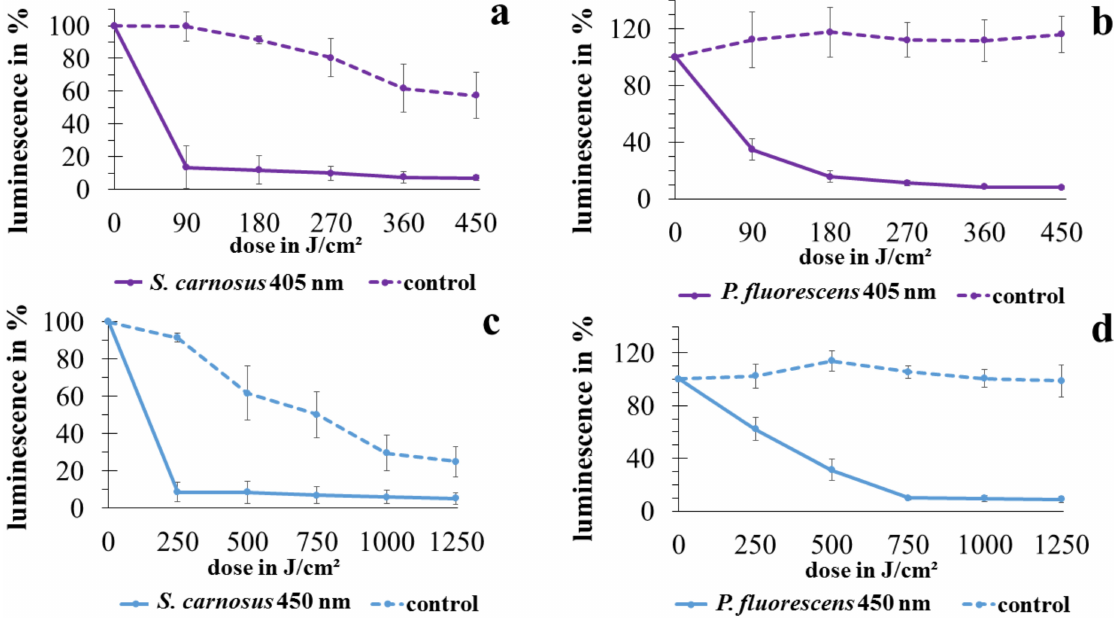
Figure 2. Luminescence progress, related to ATP content of S. carnosus irradiated with 405 nm ( a ) and 450 nm ( c ) as well as of P. fluorescens at 405 nm ( b ) and 450 nm ( d ). Error bars are representing the standard deviation of three independent exper-